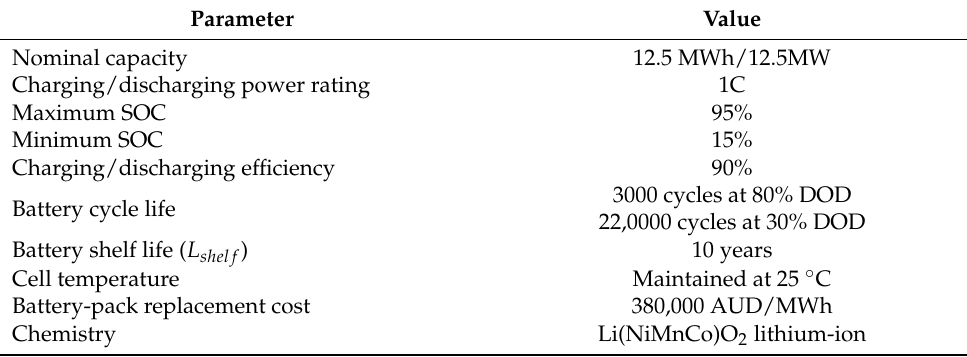
Table 3. BESS specifications [47].